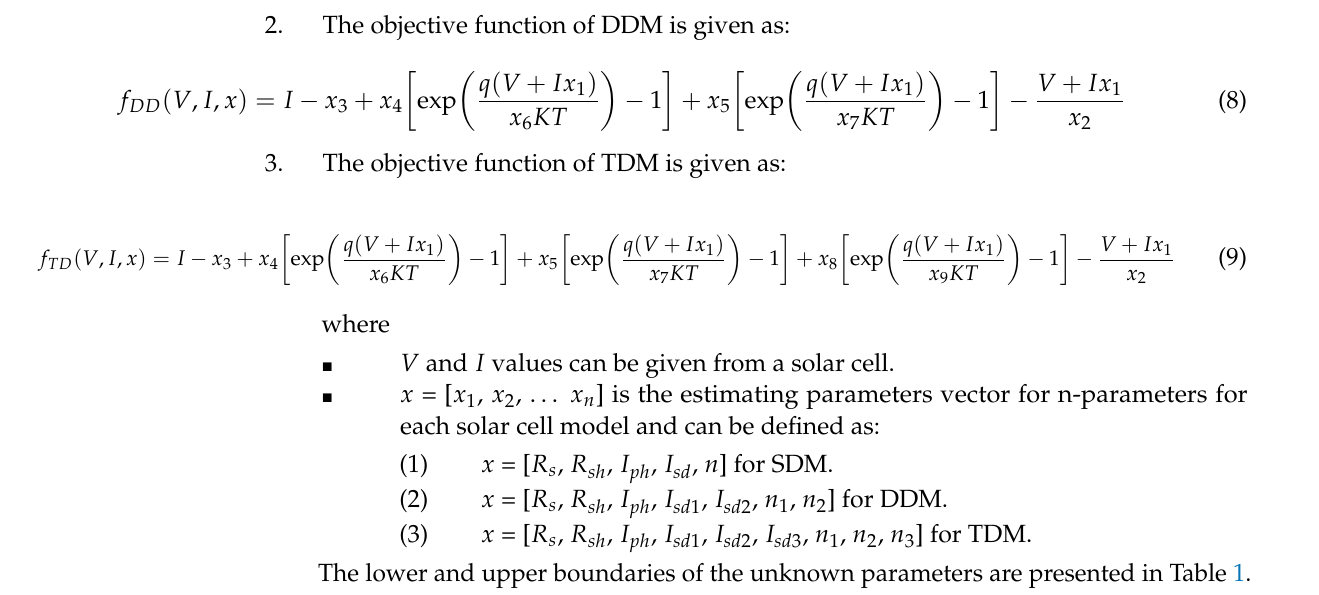
Table 1. The limits of extracted photovoltaic parameters. Parameter Lower Limit Upper